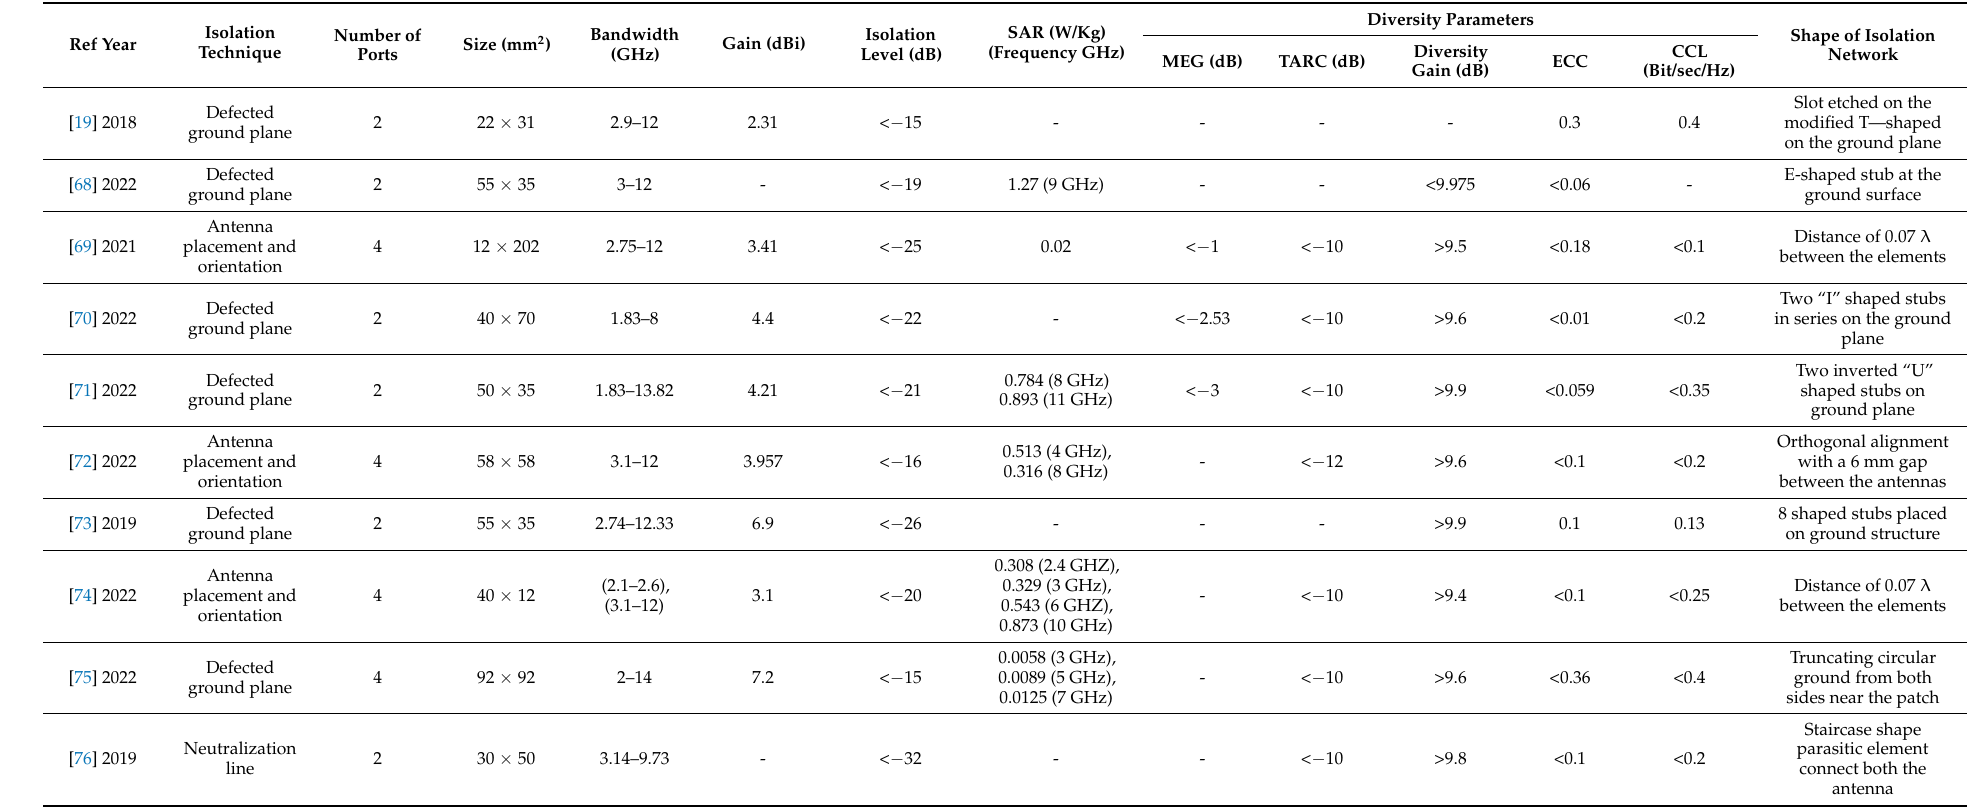
Table 5. Performance comparison of UWB MIMO